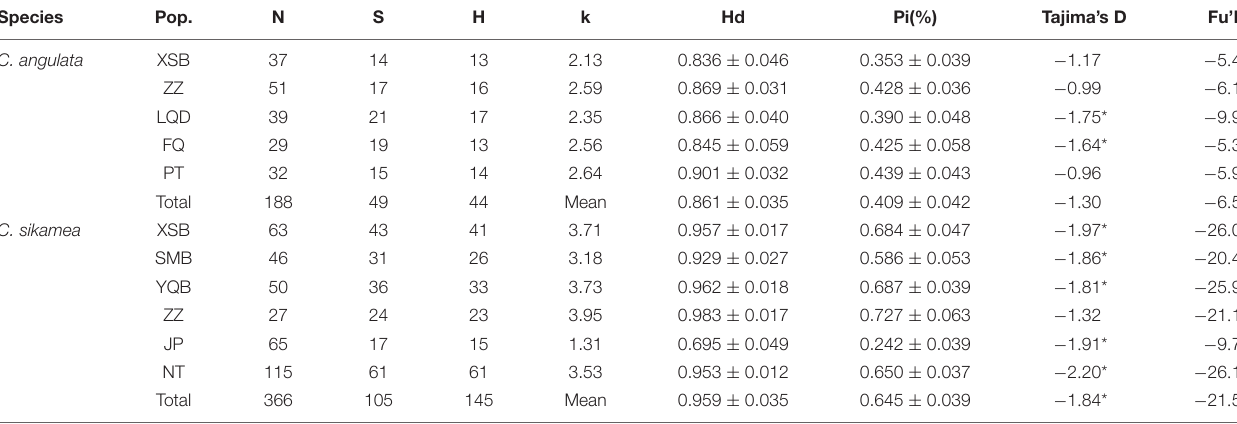
TABLE 4 | Genetic diversity parameters of Crassostrea angulata and Crassostrea sikamea based on COI sequence. Species Pop. N S H k